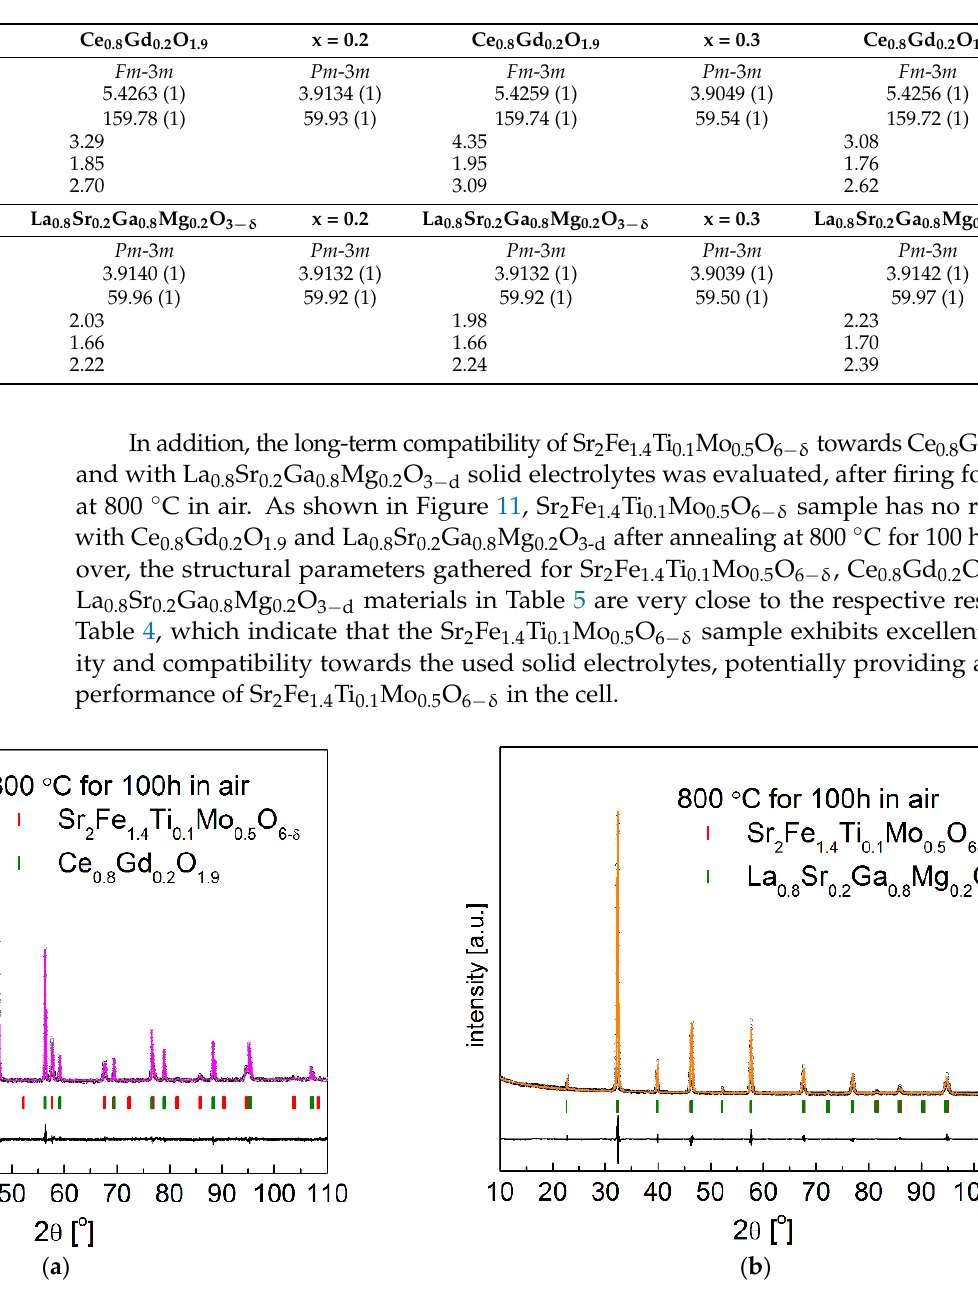
Table 4. Structural parameters of Sr 2 Fe 1.4 Ti x Mo 0.6 − x O 6 − δ (x = 0.1, 0.2 and 0.3) oxides with